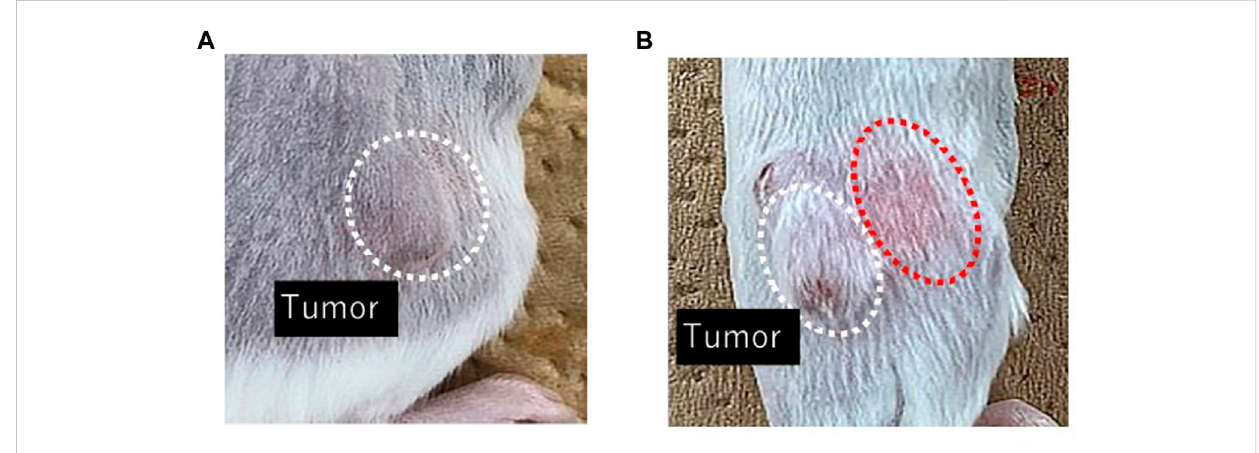
FIGURE 2 Visible observation of DXR distribution just after fi nishing drug administration with an EO pump (A) and a syringe (B) . Representative images of the area around a tumor in each group ( n = 5).